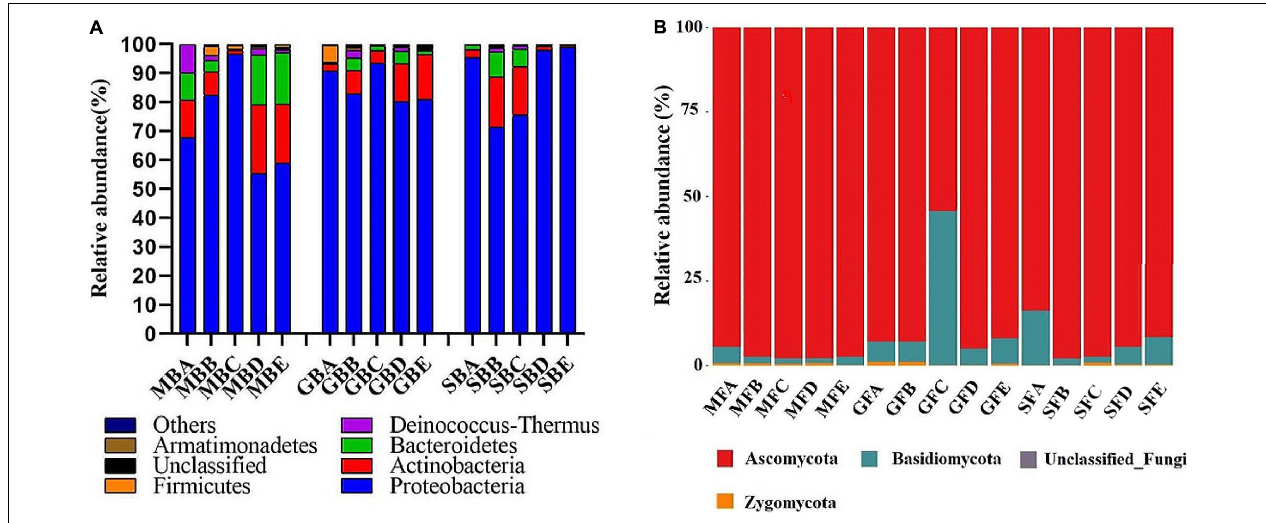
FIGURE 4 | The relative abundance of the dominant phyllosphere bacterial (A) and fungal (B) population at the phylum level. B, bacteria; F, fungi. M, seedling stage; G, heading stage; S, mature stage. (A) 580 m asl; (B) 680 m asl; (C) 780 m asl; (D) 880 m asl; (E) 980 m asl.